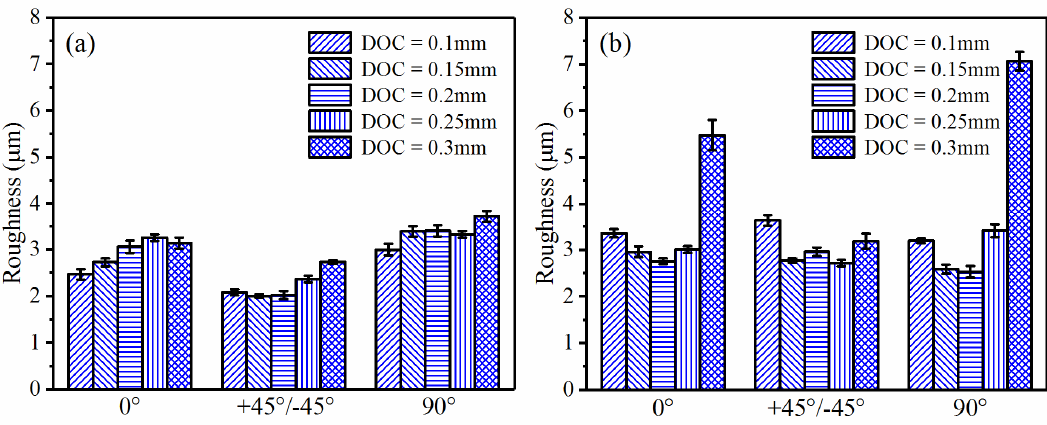
Figure 5. Roughness comparison with different RAs (LT = 0.1 mm, SS = 3000 r/min, FRT = 0.04 mm): ( a ) PEEK; ( b ) CF/PEEK.